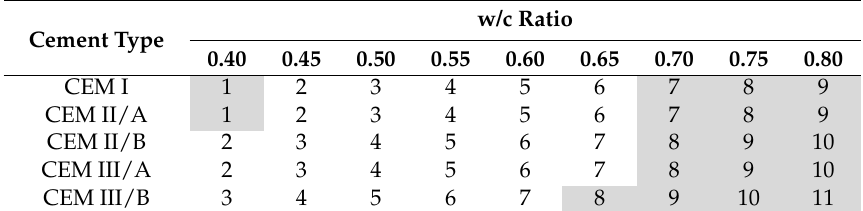
Table 2. Mean values m of carbonation rate k NAC (mm/years 0.5 ) for different combination of cement types and w/c ratios